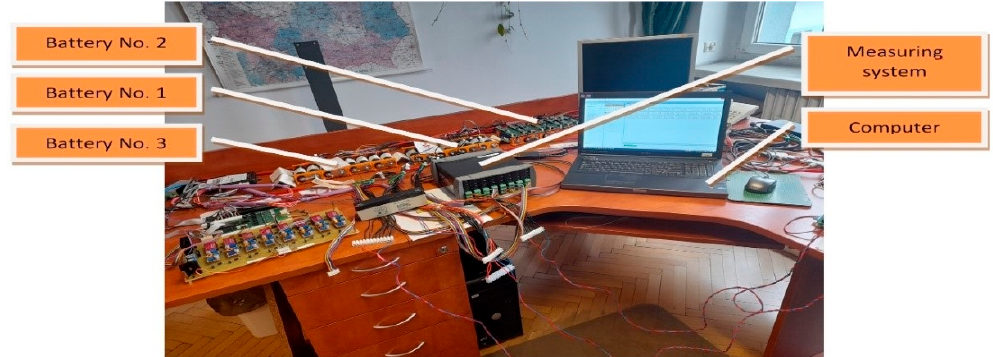
Figure 12. General view of test stand under room conditions (No. 1—with battery to cell active BMS, No. 2—with cell to battery active BMS, No. 3—with passive BMS).